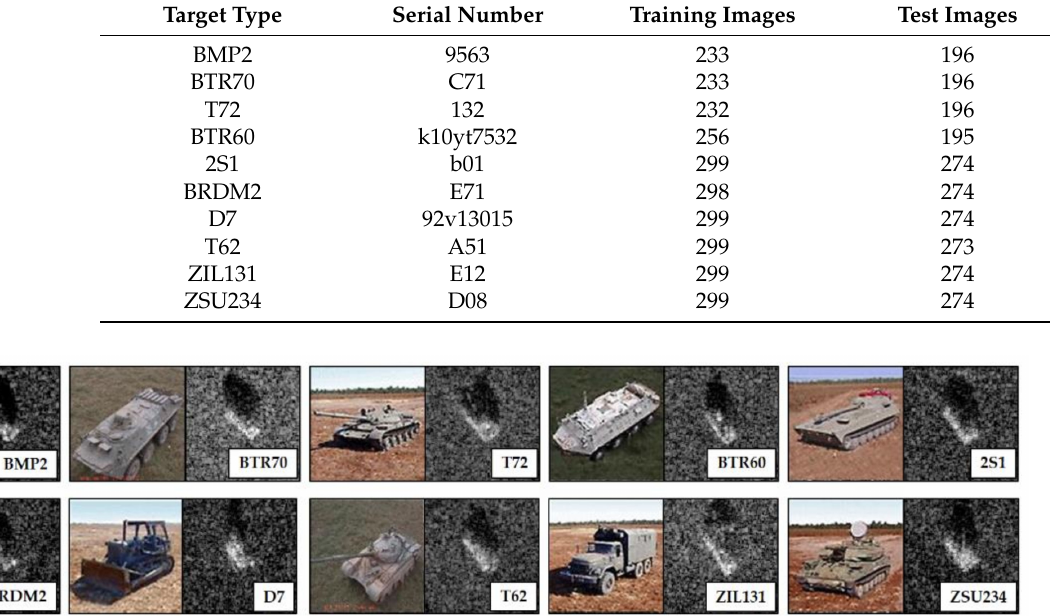
Table 1. Information on the SAR target images of MSTAR dataset collected under SOC.